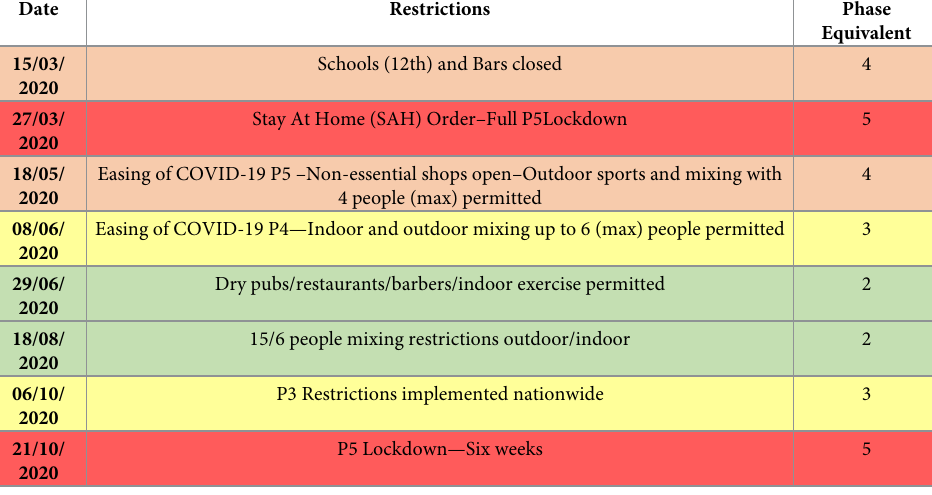
Table 2. Non-pharmaceutical Intervention (NPI) phases in the Republic of Ireland, March–November 2020. Date